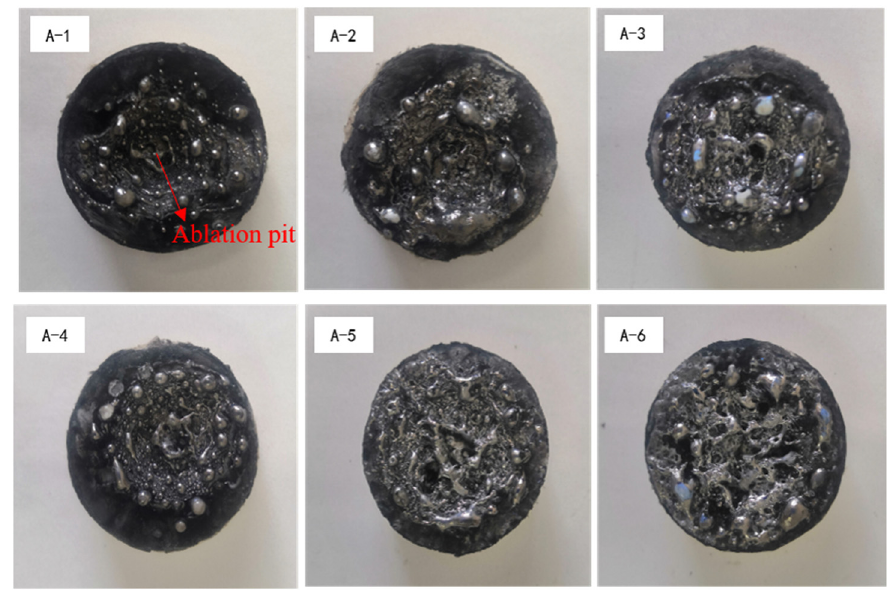
Figure 5: Surface morphology of composites.